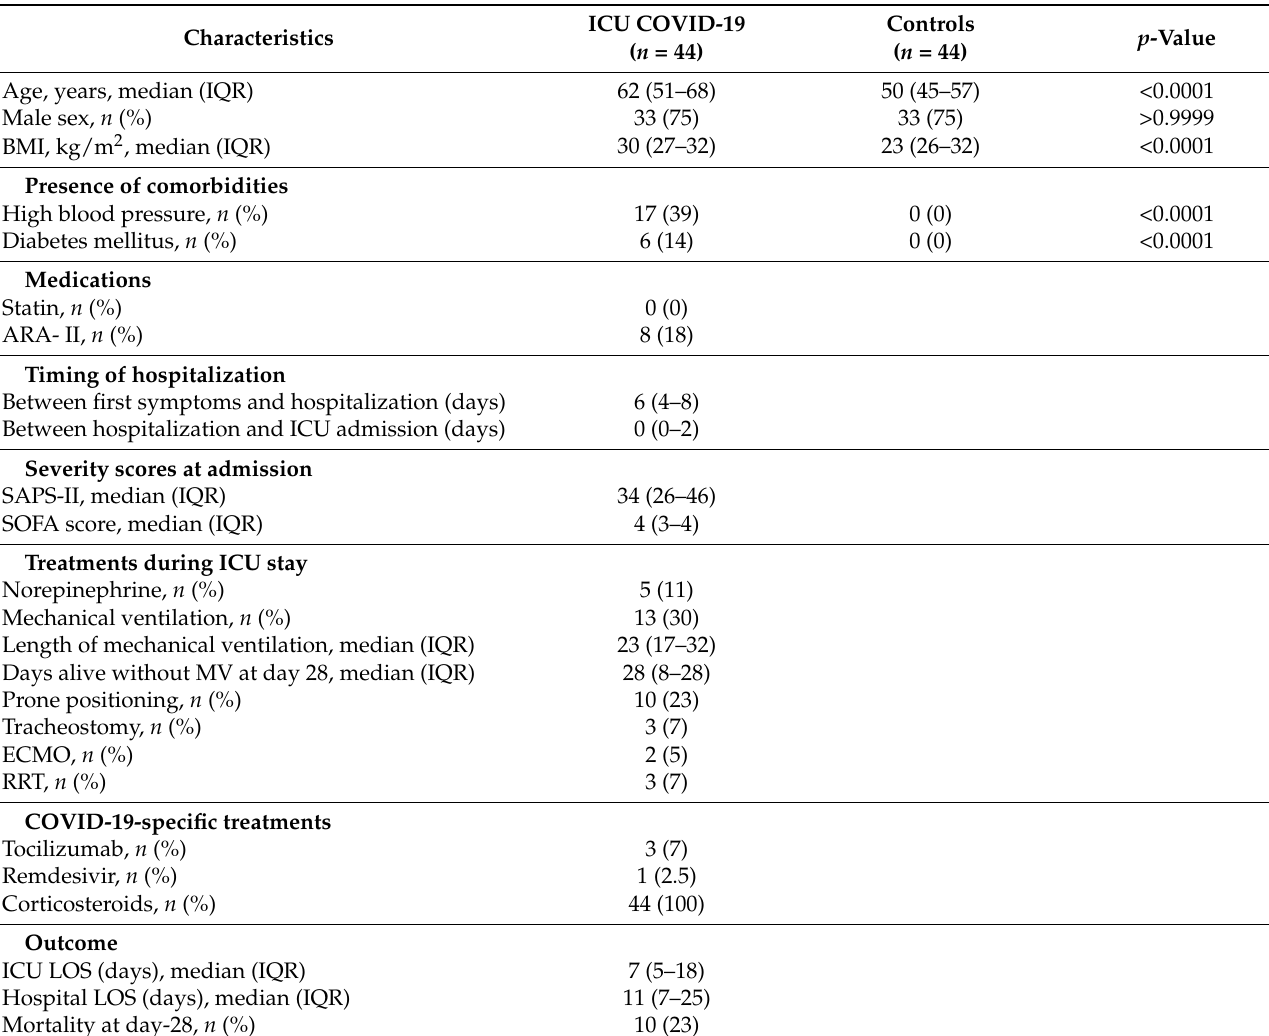
Table 1. General characteristics and outcome of ICU COVID-19 patients and control